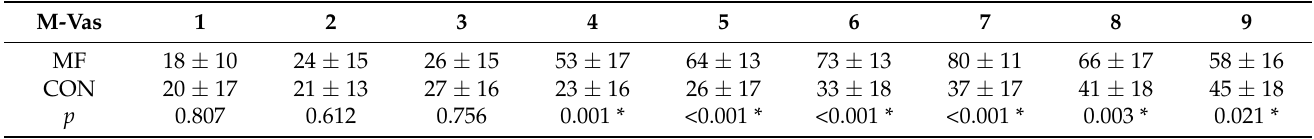
* = significant difference between the conditions; M-VAS 1= baseline; M-VAS 2= right after the first Fitlight task; M-VAS 3 = right after the first flanker task, just before the start of the Stroop task; M-VAS-4,5,6 = throughout the Stroop task; M-VAS 7 = at the end of the Stroop task; M-VAS 8 = right after the second flanker task; M-VAS 9 = at the end of the second Fitlight task.3.4.2. Behavioural (Stroop and